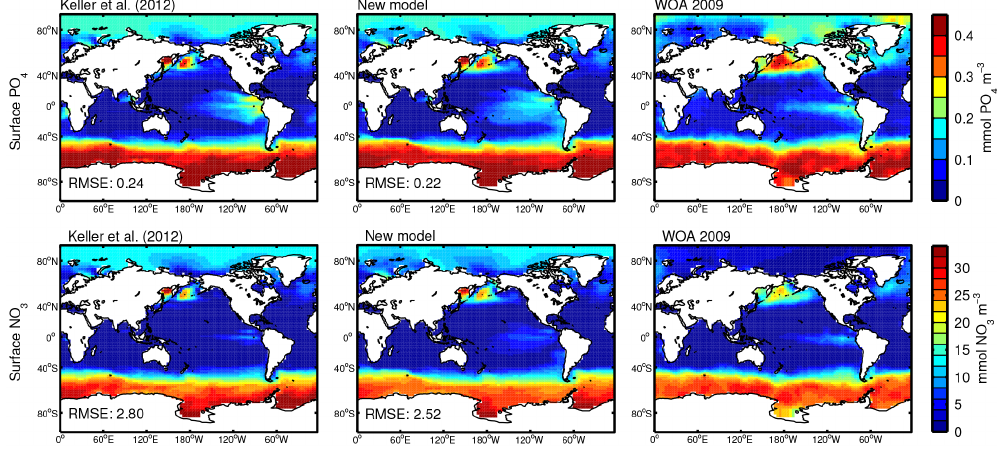
Figure 8. Annual mean surface phosphate (first row) and nitrate concentrations (second row) for the model by Keller et al. (2012) and the new model in comparison to observations from the World Ocean Atlas 2009 (WOA, 2009) (Garcia et al., 2010b).